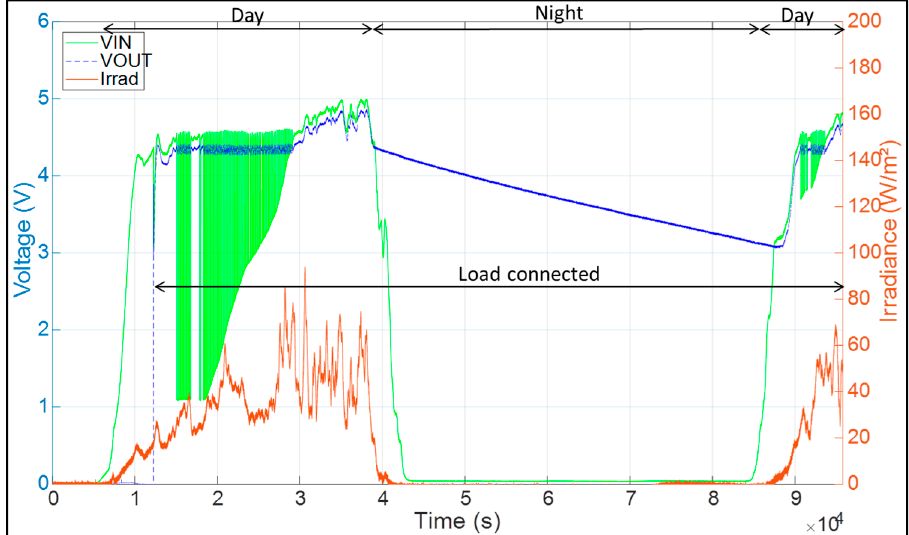
Figure 15. Implementation of the proposed variable storage architecture (with C small = 100 mF and C big = 2.5 F) into a wireless sensor node powered by a photovoltaic cell (PV): evolution of irradiance, input and output voltages of adaptive UC over one day and a half with very bad meteorological conditions.